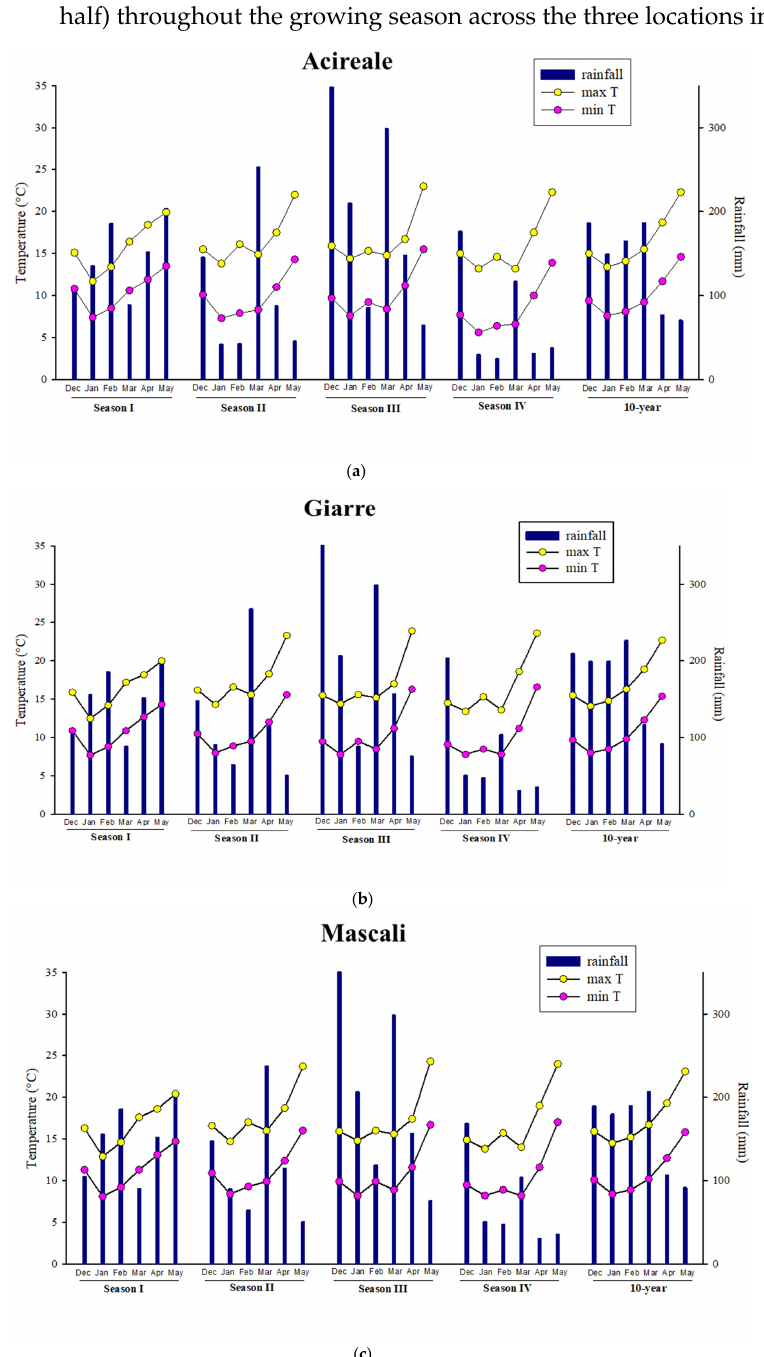
Figure 1. Monthly rainfall, average minima and maxima monthly air temperatures, and 10-year (2013–2022) climatic trend in Acireale ( a ), Giarre ( b ), and Mascali ( c ) throughout Season I (2018– 2019), Season II (2019–2020), Season III (2020–2021), and Season IV (2021–2022).